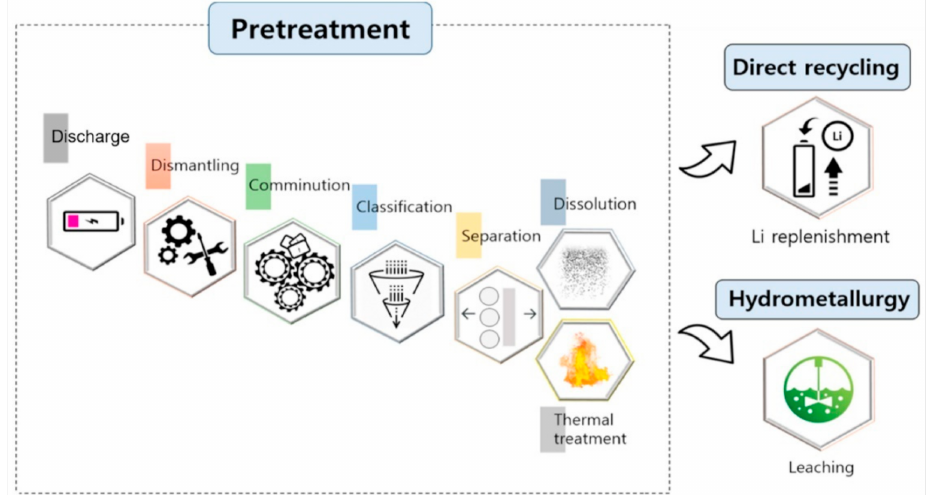
Figure 4. The scope and the sequence of the pretreatment process in LIB recycling [11]. Reprinted from Journal of Cleaner Production, Vol. 294, S. Kim et al., A comprehensive review on the pretreatment process in lithium-ion battery recycling, no. 8, pp. 1–29, Copyright (2021), with permission from